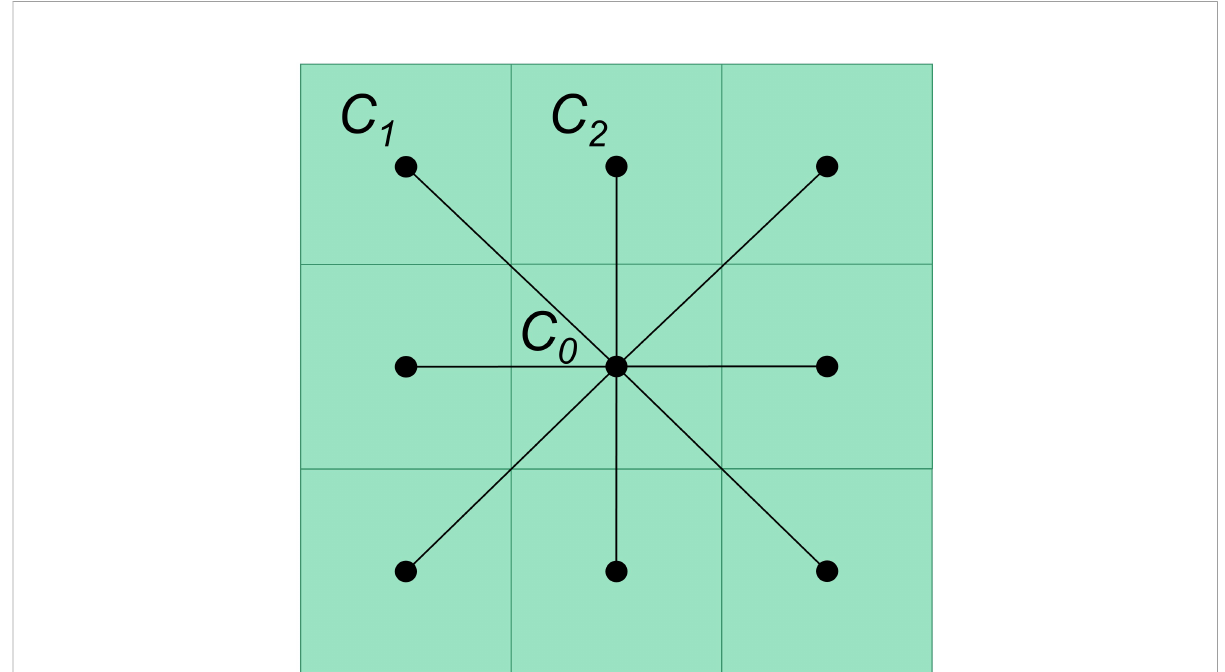
FIGURE 1 Illustration of nodes and edges in the raster map. Dots represent the nodes, lines that connected dot pairs represent the edges, and cells in the background grid represent pixels in a